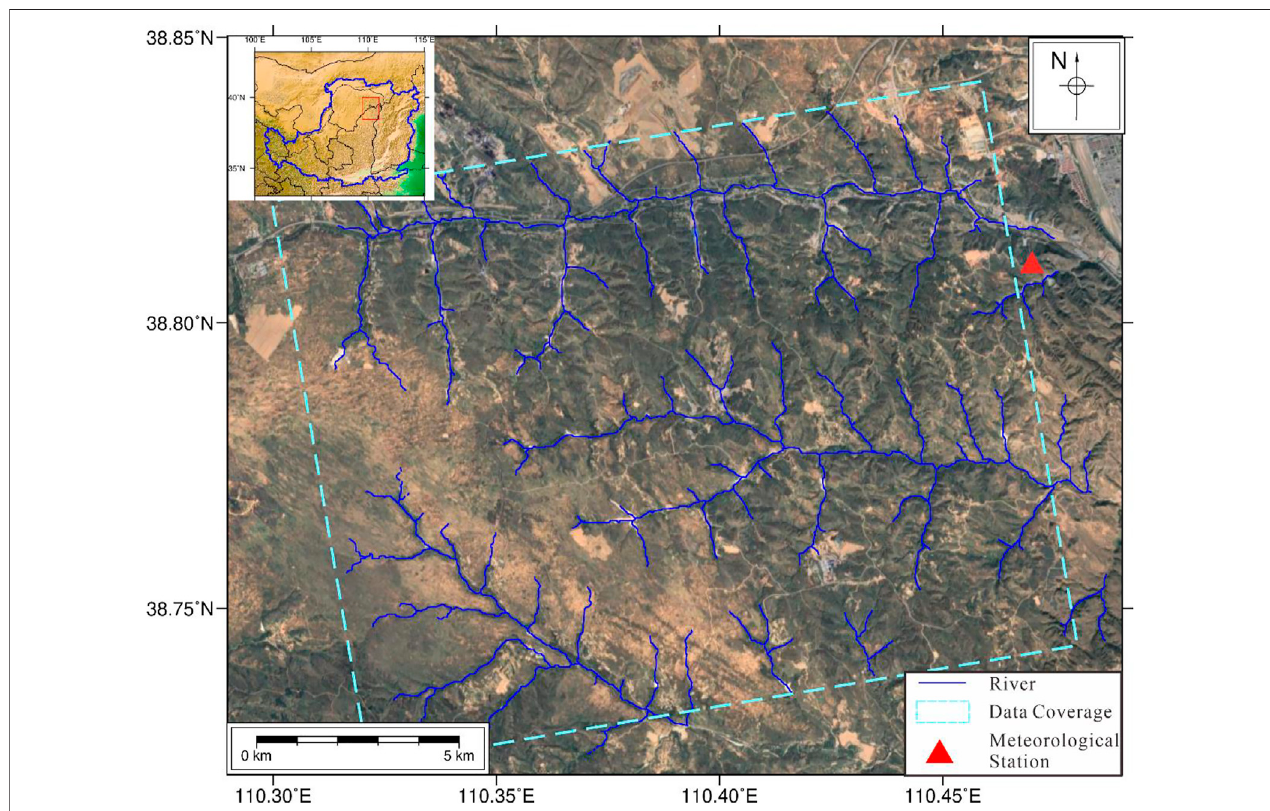
FIGURE 1 | Optical image of the study area. Dashed blue rectangle outlines the coverage of the selected Sentinel-1A images. Solid blue line indicates the distribution of ditches. Red triangle indicates the location of Shenmu meteorological station. The inset shows the approximation the area location in the Loess Plateau.